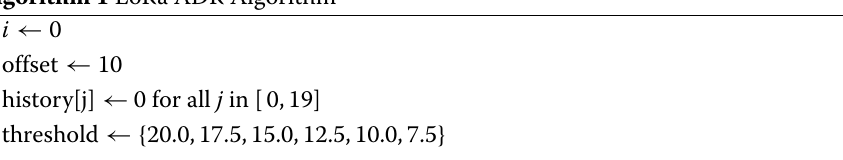
Algorithm 1 LoRa ADR